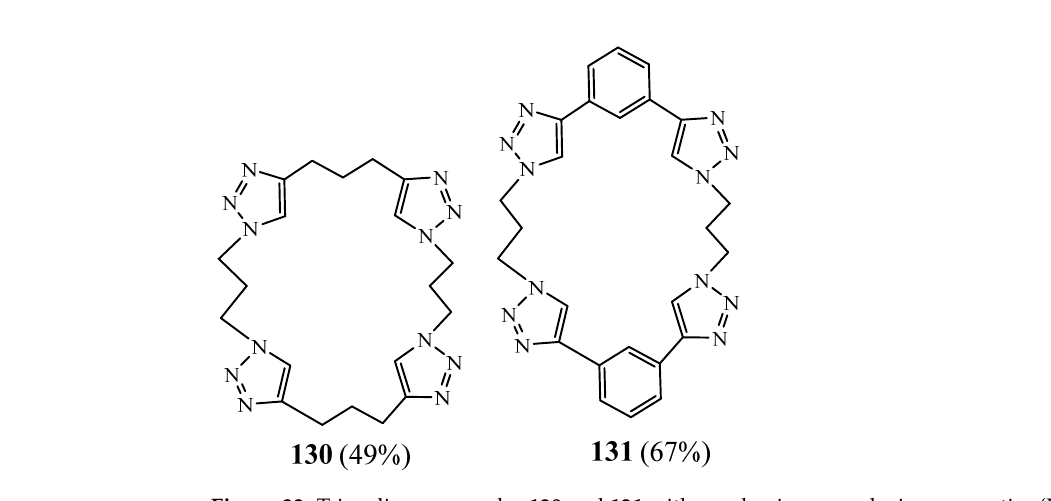
Figure 33. Triazolic macrocycles 130 and 131 with good anion-complexing properties. (Reprinted with permission from ref. [54]. Copyright 2012 Royal Society of Chemistry).